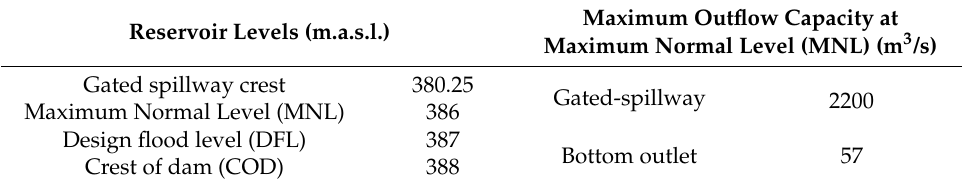
Table 1. Characteristic reservoir levels (in meters above sea level (m.a.s.l.)) and spillway of the dam configuration